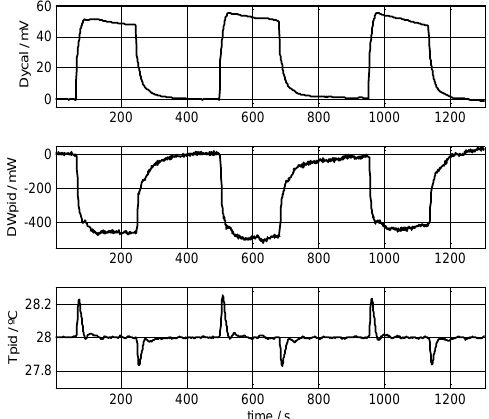
Figure 12. Three consecutive measurements made on the left wrist of a healthy, 22-year-old male subject. Calculated mean powers: 199, 214 and 219 mW (209 ± 10 mW) at T room = 21.4 °C, T pid = 28.0 °C. The baselines of the curves for the calorimetric signal and the thermostat’s power were corrected. Thermostat temperature is also shown ( T pid ). V Peltier = 0.2 V.